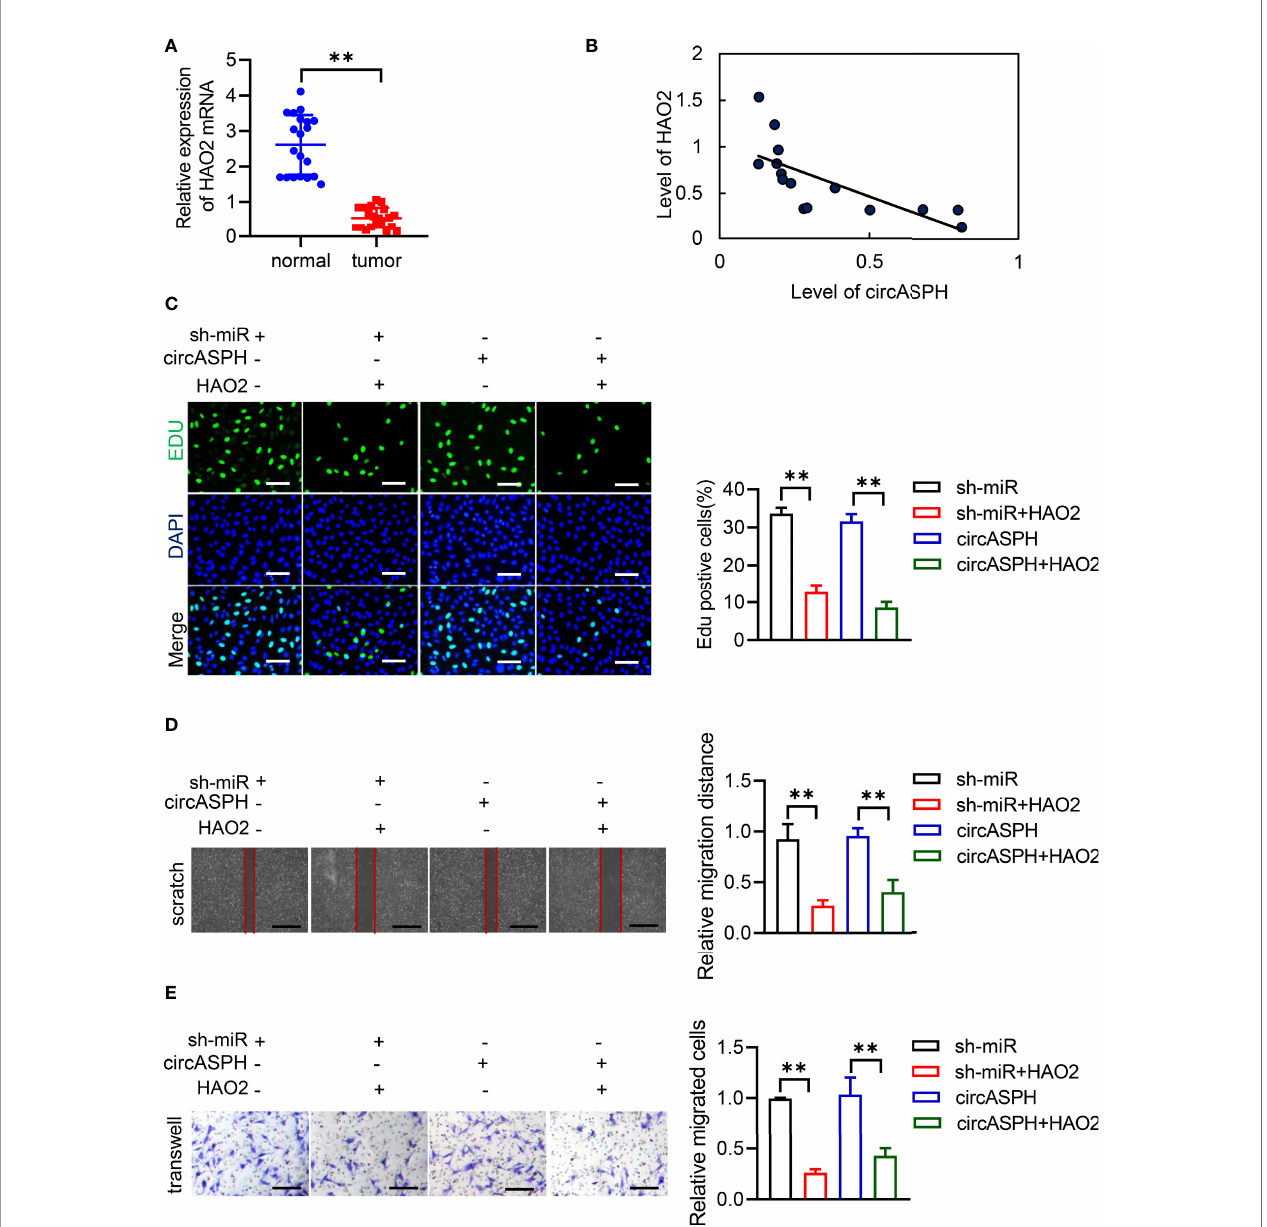
FIGURE 7 | CircASPH promoted the HCC process via the miR-370-3p/DNMT3b/5mC/HAO2 axis. (A) The level of HAO2 expression was evaluated by RT-qPCR in 20 paired HCC tumor tissues and normal tissues. (B) Pearson analysis indicated the relationship between circASPH and HAO2. (C) EDU staining assays indicated the proliferation of cells expressing a combination of circASPH, sh-miR-370-3p, and HAO2. (D, E) Wound-healing assays and Transwell assays indicated the ability of migration and invasion of cells by expressing a combination of circASPH, sh-miR-370-3p, and HAO2. **p <